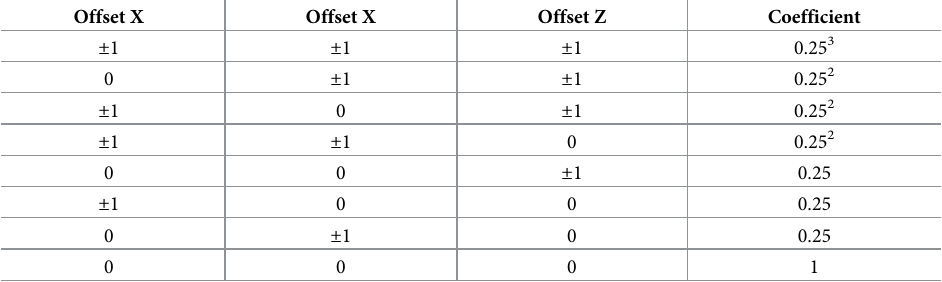
Table 1. Coefficients of the filter used in computing the histogram in a cell for SIFT features.